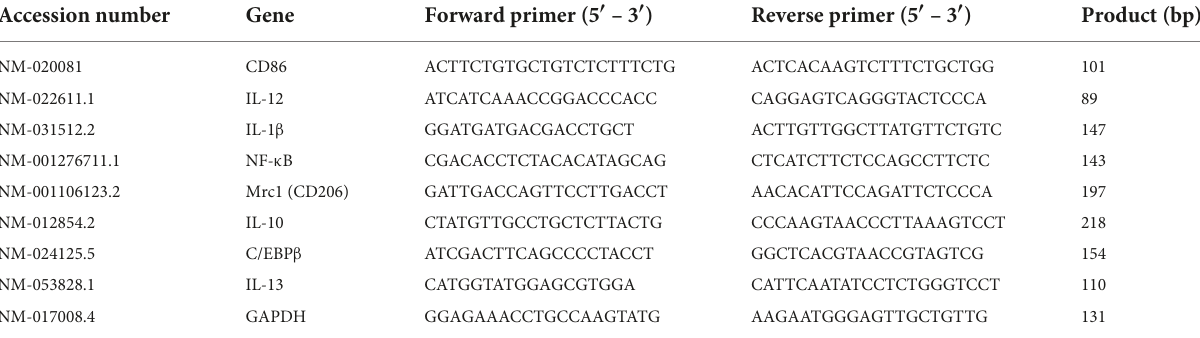
TABLE 1 Primer sequences used for real-time